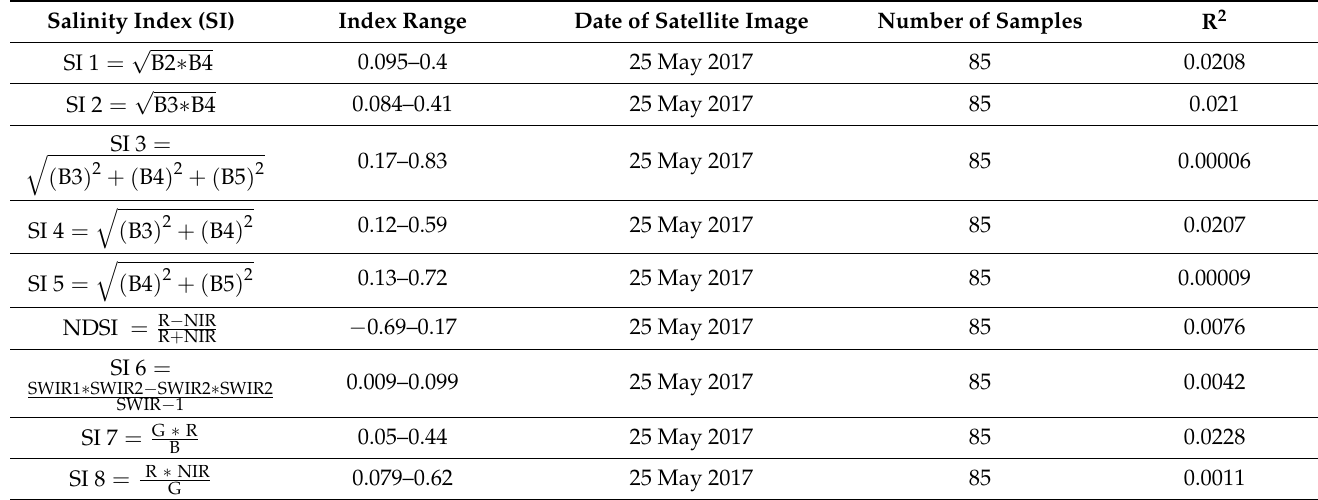
Table 5. Linear regression analysis results for nine different salinity